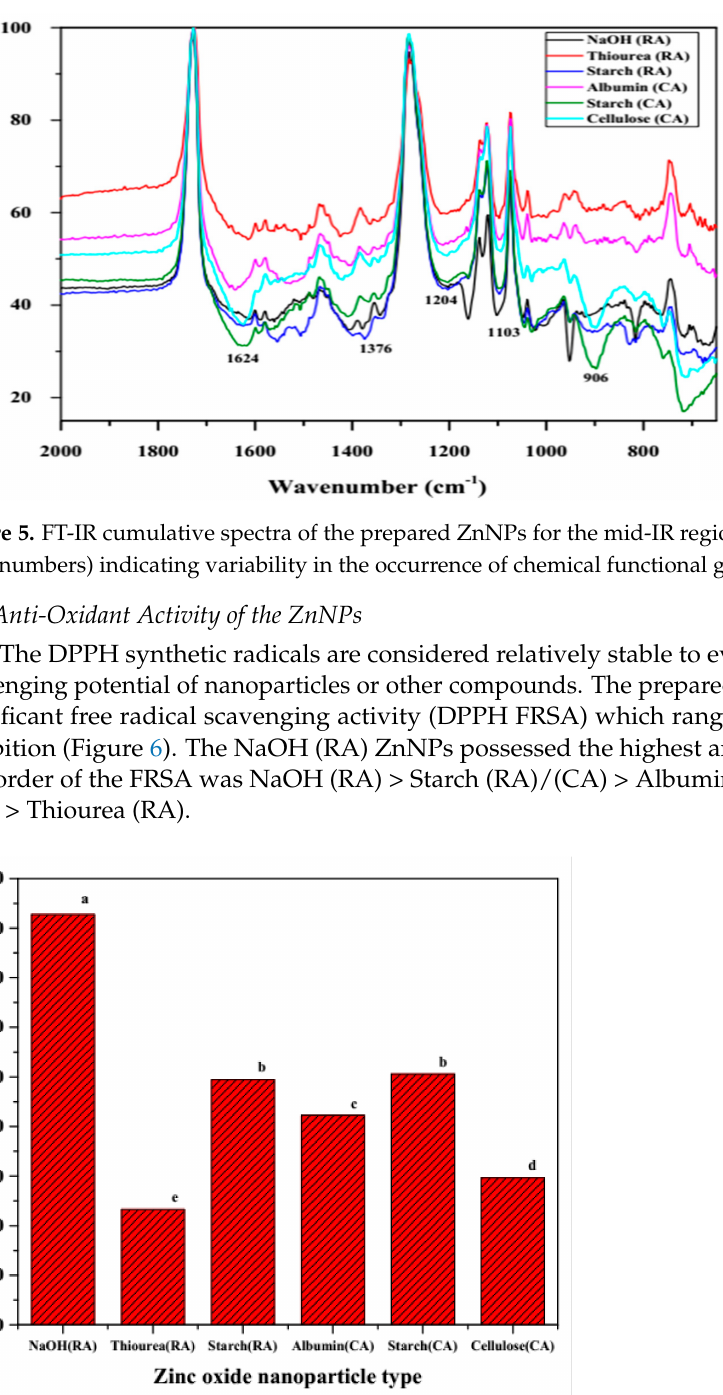
Figure 6. Comparative antioxidant potential of ZnNPs as determined through scavenging activity (%) of DPPH radicals. Different letters denote a significant difference ( p ≤ 0.05) among six different types of